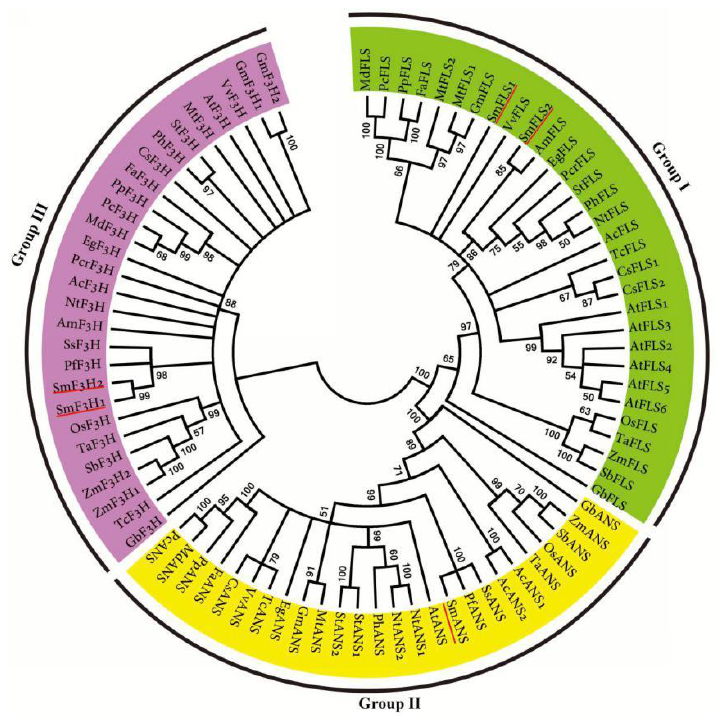
Figure 6. The phylogenetic relationship of FLS, F3H and ANS proteins. The amino acid sequences of flavonoid biosynthesis-related 2-ODDs, including FLS, F3H and ANS, were obtained from NCBI under the accession numbers listed in Supplementary Table S7.